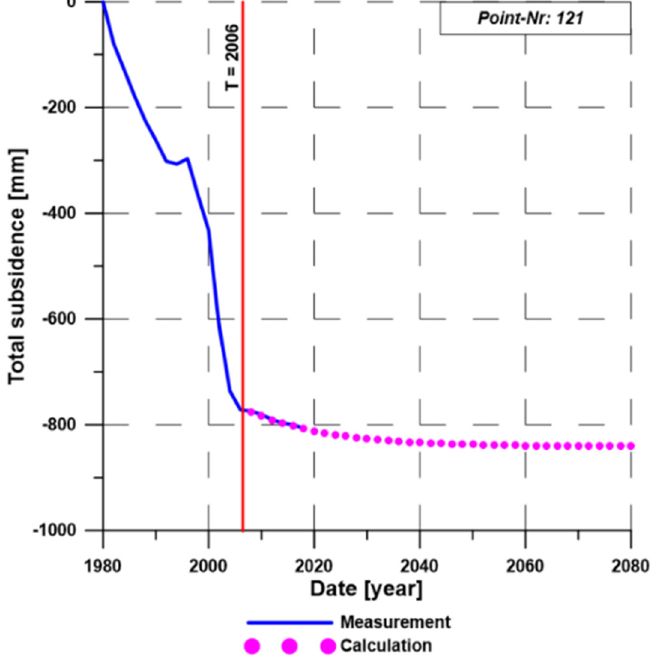
Figure 5. The course of subsidence until 2018 and the prediction of residual subsidence for the point no. 121.